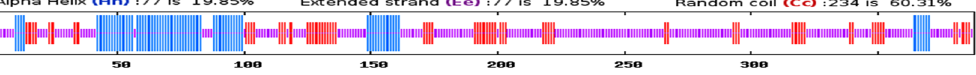
Figure 1. Secondary structure analysis of the Ror1 protein.